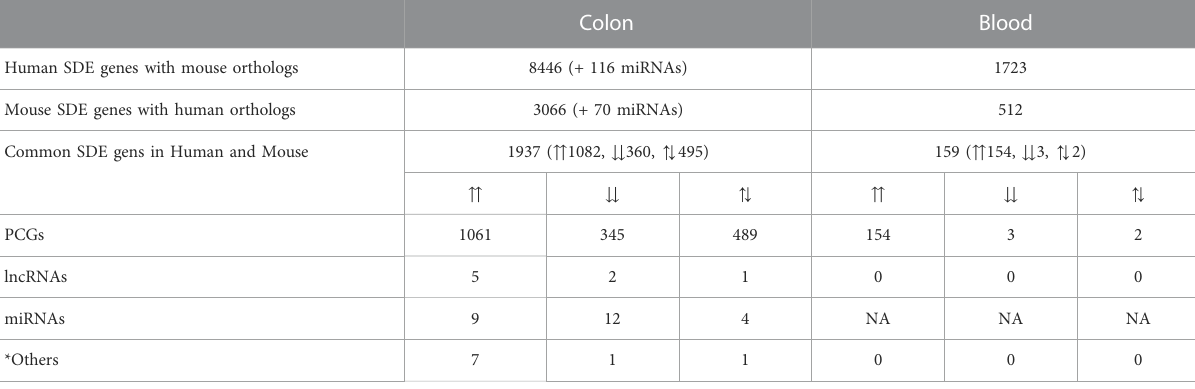
TABLE 4 Numbers of overlapping genes between UC mouse and UC human colon and blood (For all padj ≤ 0.05). ⇈ : Upregulation in both mouse and human, ⇊ : Downregulation in both mouse and human, d : Opposite directions between mouse and human